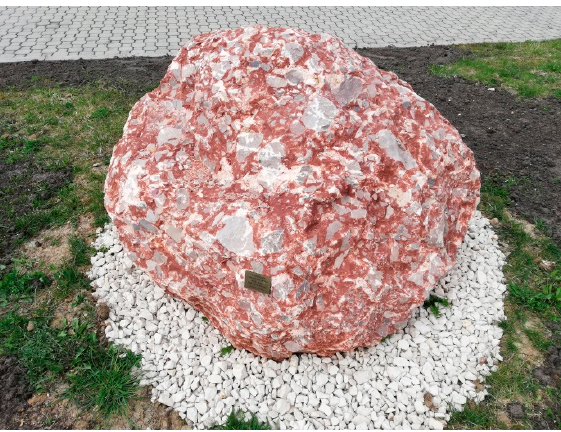
Figure 10. Fragment of the Late Permian Sigismundus (Zygmuntowski) conglomerate composed of limestone debris (No. 14).